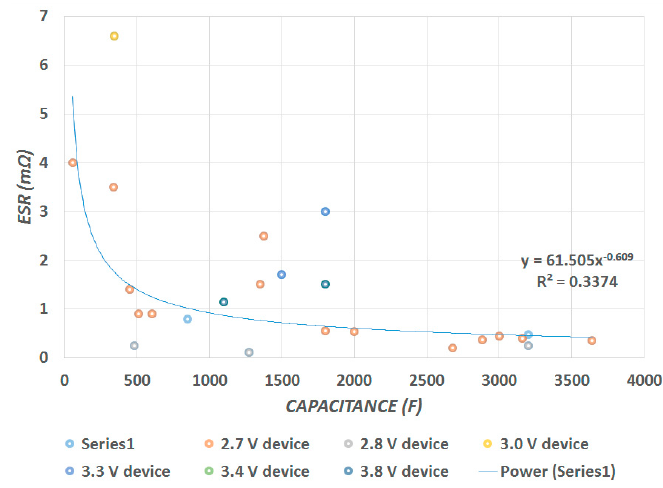
Figure 4. Equivalent series resistance vs. capacitance, ESR ∝ ( cap 0.609 ) − 1 .